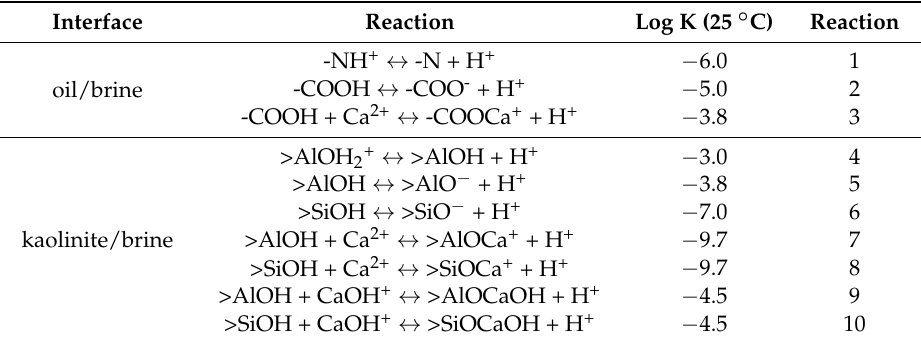
Table 1. Surface complexation model input parameters